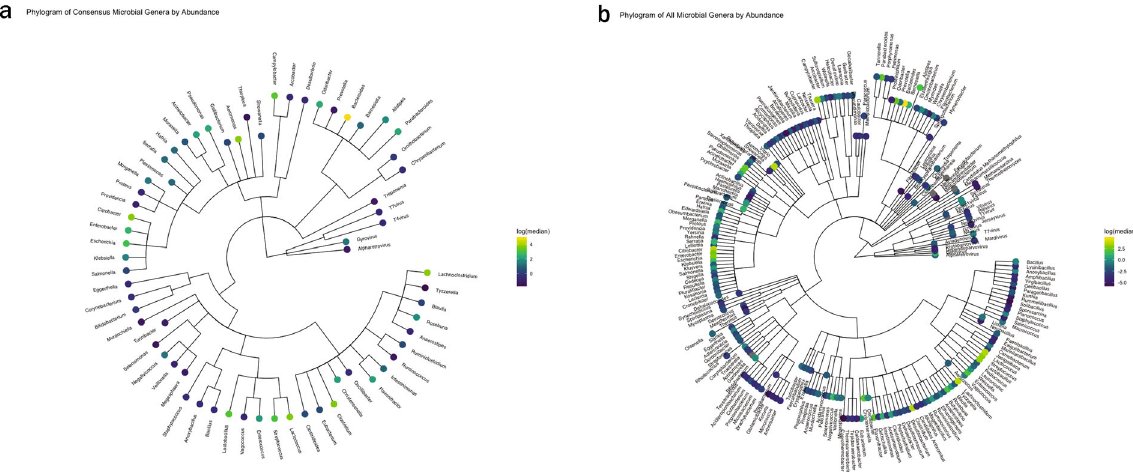
Fig. 3 Microbial genera detected in high protein powder samples. a Phylogram of the 65 microbial genera present in all samples with RPM > 0.1. b Phylogram of microbes observed in any sample. Log of the median RPM value across samples is indicated. Gray indicating a median RPM value of 0.